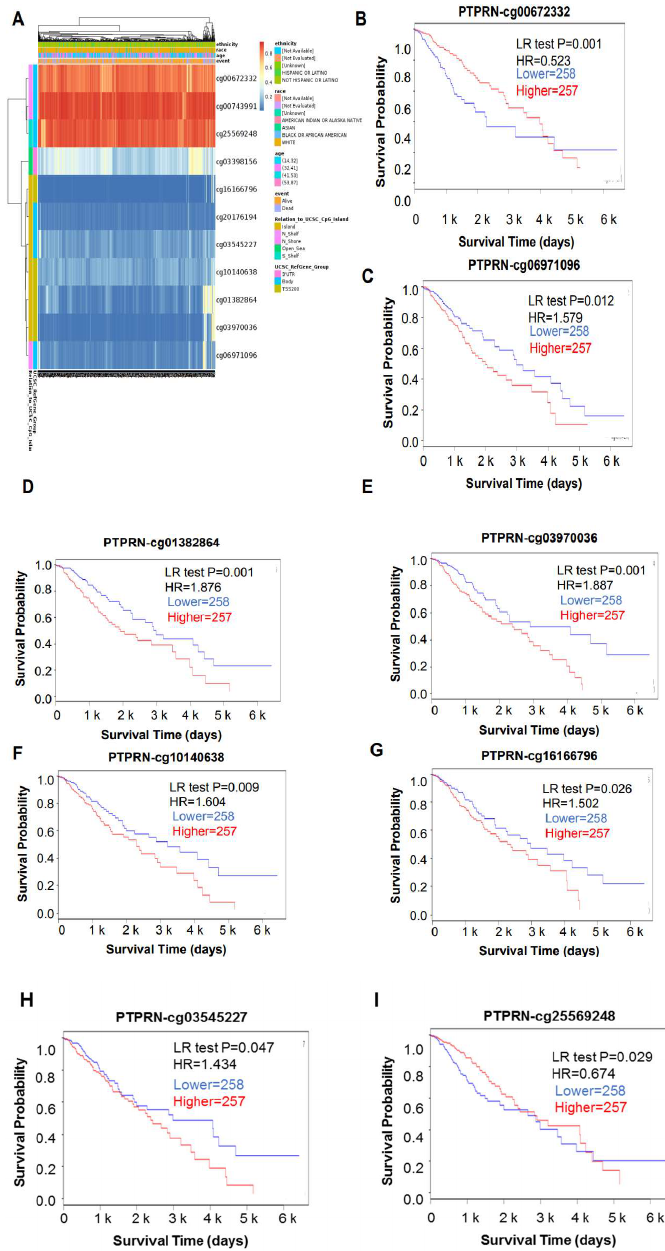
Figure 3. The DNA methylation of PTPRN in LGG of TCGA. ( A ) Heatmap of DNA methylation expression levels of the PTPRN gene in LGG by MethSurv platform. ( B – I ) Prognostic values of single CpG of the PTPRN gene in LGG. The threshold of significance was LR Test p value < 0.05. cg00672332, cg06971096, cg01382864, cg03970036, cg10140638, cg16166796, cg03545227, and cg25569248 of PTPRN displays the significant level of DNA methylation in